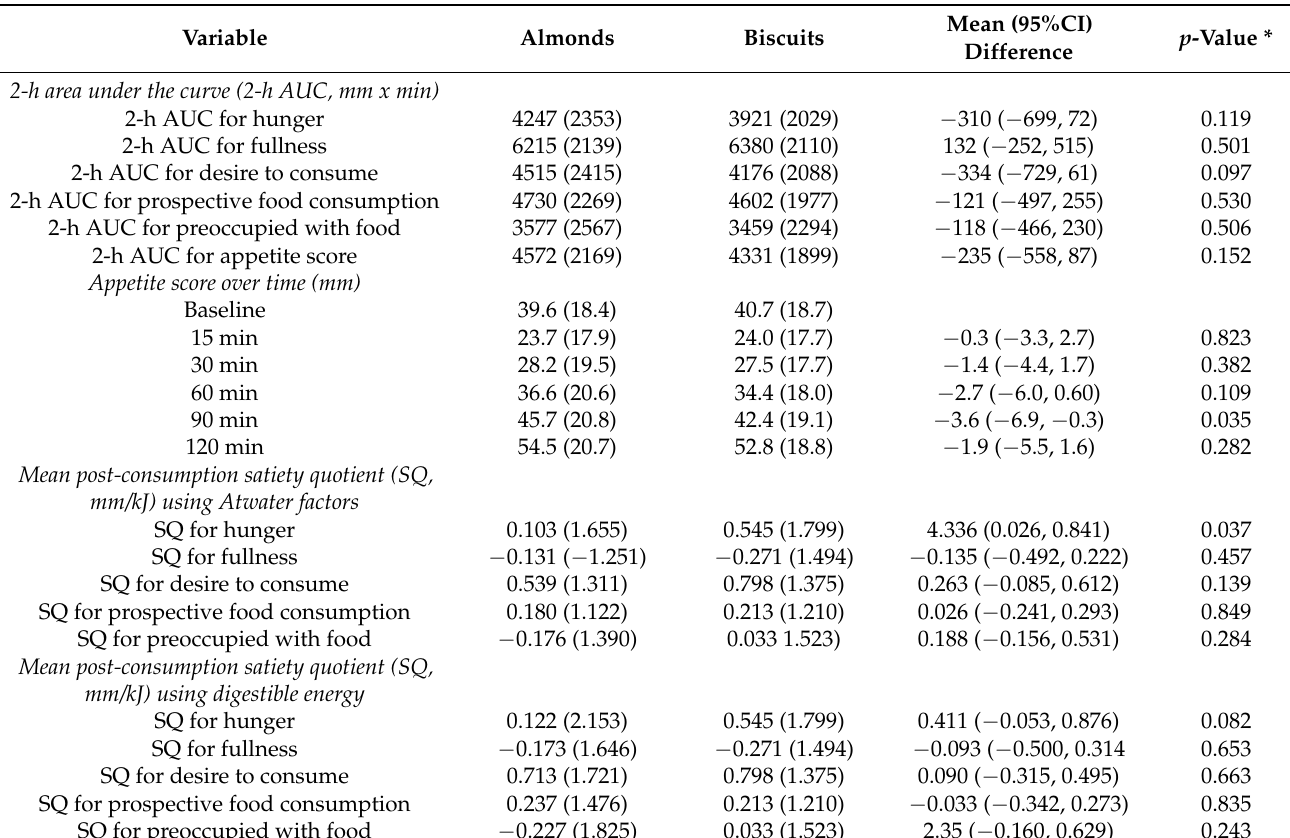
Table 3. Mean (SD) two-hour area under the curve (AUC) and satiety quotient for each appetite rating, and appetite score over